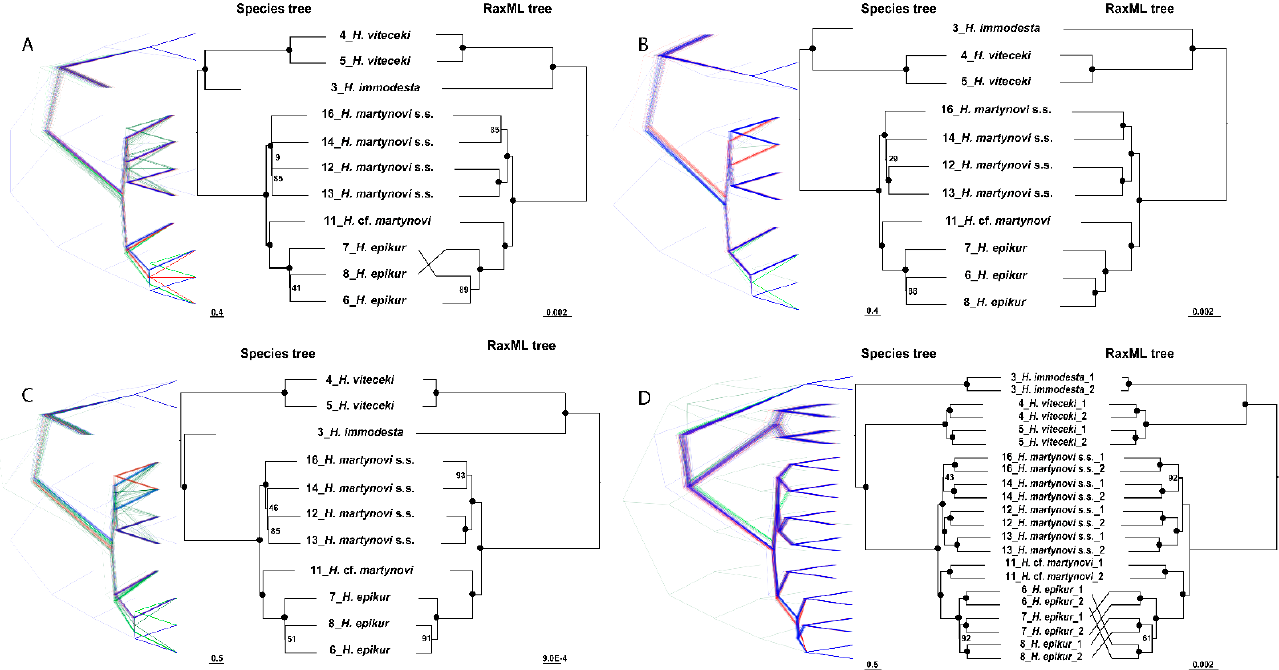
Figure 2. Species tree with 691 loci (left) and RaxML tree with the concatenated loci (right) for Himalopsyche martynovi complex based on four datasets used in this study: ( A ) with allele 1; ( B ) with allele 2; ( C ) with the merged allele based on IUPAC code. On each figure, the left part shows a plot of the complete bootstrap species tree distribution using DensiTree ( D ). The black circle on the branch node represents bootstrap scores above 96, otherwise is shown with numbers. H. martynovi s.s. is the abbreviation of H. martynovi sensu stricto.